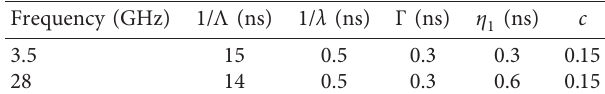
Figure 9: Examples of clustering of measured PDPs for both measured frequencies at 2.2m Tx-Rx distance (step 5 of the stair): (a) 3.5 GHz and (b) 28GHz. Table 3: S-V model